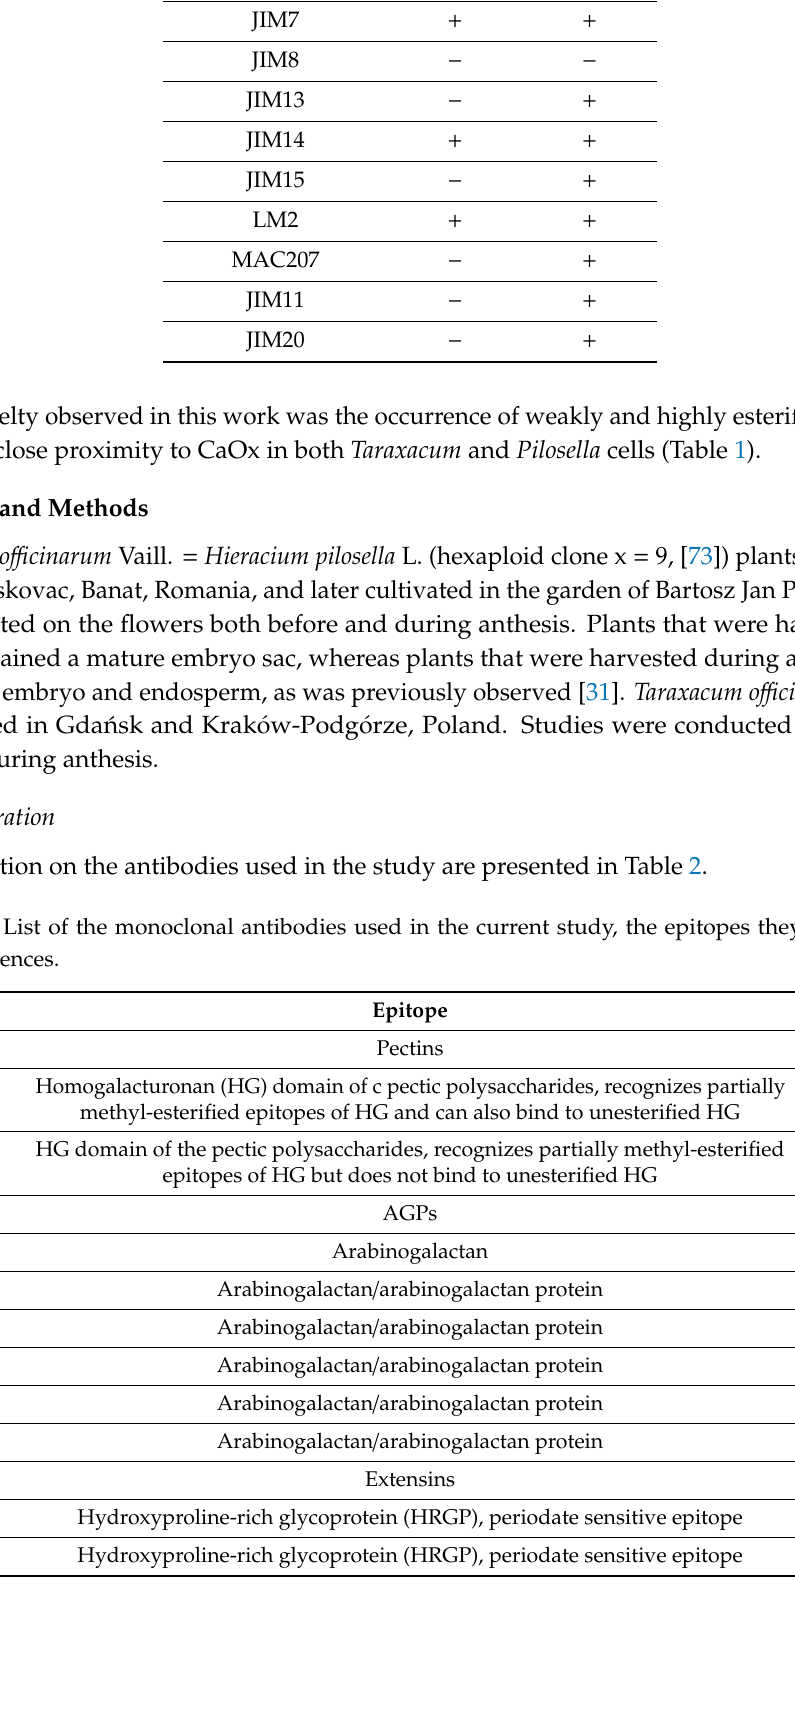
Table 1. Association of calcium oxalate crystals in the parenchyma cells in Taraxacum and Pilosella . Antibody / Species Taraxacum Pilosella JIM5